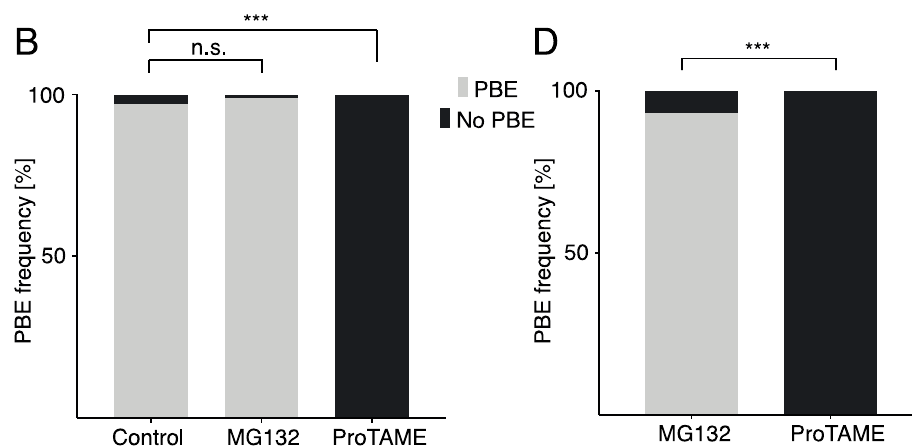
Figure 4. ProTAME-induced arrest in mouse oocytes is irreversible. ( A ) Germinal vesicle (GV) oocytes were matured for 5 h and then divided into three groups: the control group, MG132-treated group and proTAME-treated group. The control group was incubated overnight in M16 media. MG132 and proTAME groups were exposed to inhibitors for 3 h, washed out and incubated overnight in M16 media. The frequency of PBE was scored following overnight (ON) incubation. ( B ) The frequency of PBE in control oocytes ( n = 70), oocytes in 10 µ M MG132 ( n = 79) and oocytes in 5 µ M proTAME ( n = 81) was scored. A total of 97% of control cells, 99% of cells after MG132 and 0% of cells after proTAME extruded polar bodies (PBs). Data were obtained in three independent experiments. The difference between the control and MG132 is not statistically significant ( α < 0.05; p = 0.6008). The difference between the control and proTAME is statistically significant ( α < 0.05; *** p < 0.0001). ( C ) GV oocytes were matured for 7 h and then divided into two groups; one was treated with MG132 and the other with proTAME for 3 h and subsequently cultured in M16 without inhibitors while PBE was monitored by live cell microscopy ON. ( D ) The frequency of PBE in oocytes after 10 µ M MG132 ( n = 43) and 5 µ M proTAME ( n = 51) was scored. A total of 93% of cells after MG132 and 0% of cells after proTAME extruded PBs. Data were obtained in two independent experiments. The difference between both groups is statistically significant ( α < 0.05; *** p < 0.0001).